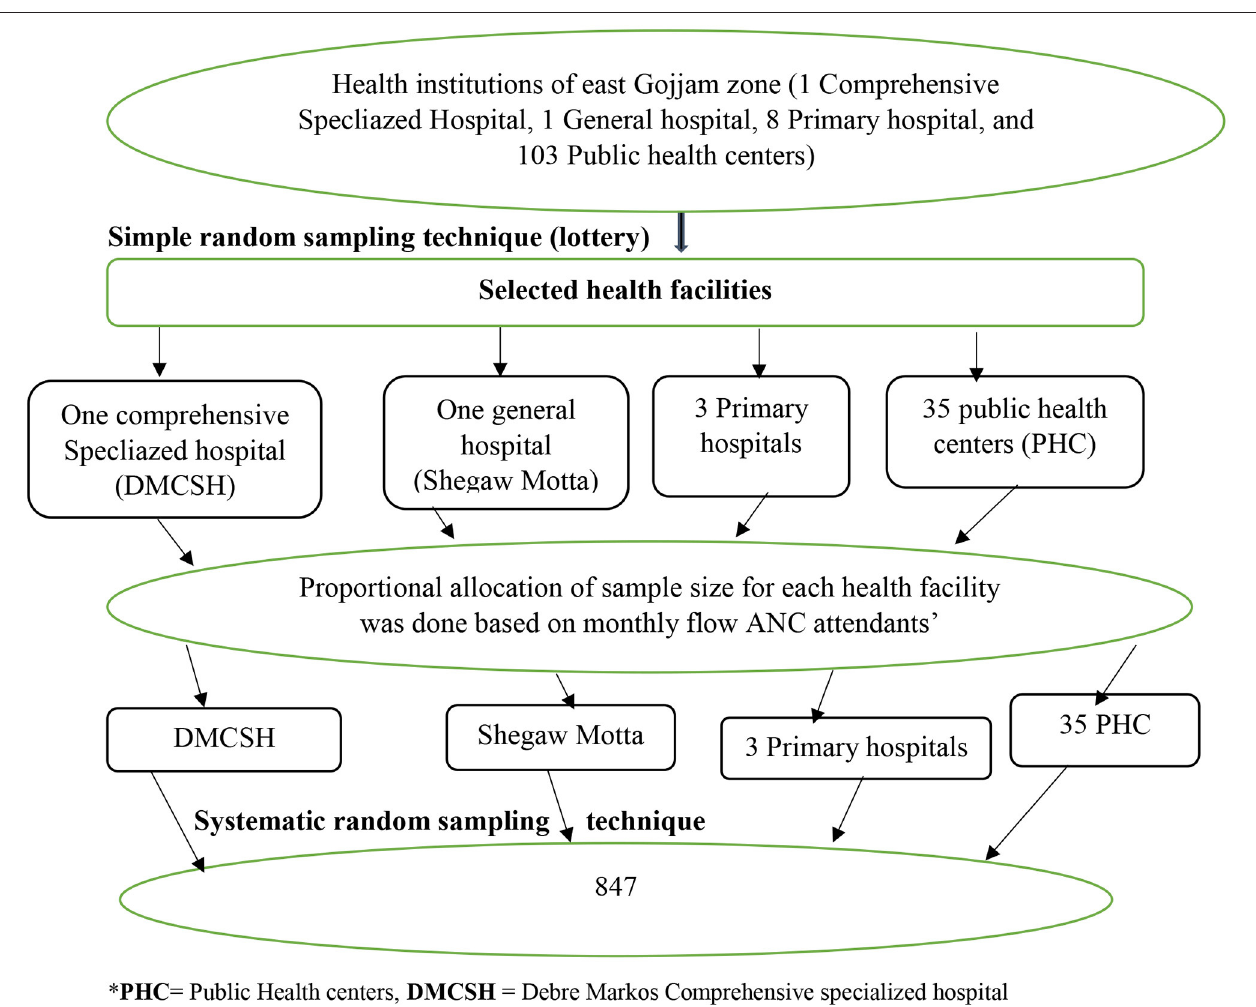
FIGURE 1 | Diagrammatic presentation of the sampling procedure to assess generalized anxiety disorder and associated factors during COVID-19 pandemic among pregnant women attending antenatal care in East Gojjam zone public health facilities, 2020. PHC = Amber, Den, Wuseta, Mislewash, Kurar, Jamma, TsidMaryam, Wojel, Yesenbet, Waber, Gozamin, Yetnora, Weynwuha, Yelamgej, Debrework, Amba Maryam, Jeremis, Kuyy, Yebabat, Amanuel, Dega Segnin,Yekebabat, Debre-Elias, Gofichima, Genet, Kork, Guayi, Debre Markos, Angot, Sedie, Gundewoyn, Gietie Semanni, Girraram, Mergechi, Gemborie. Primary hospitals: Lumame, Bichena and Yejubie Primary